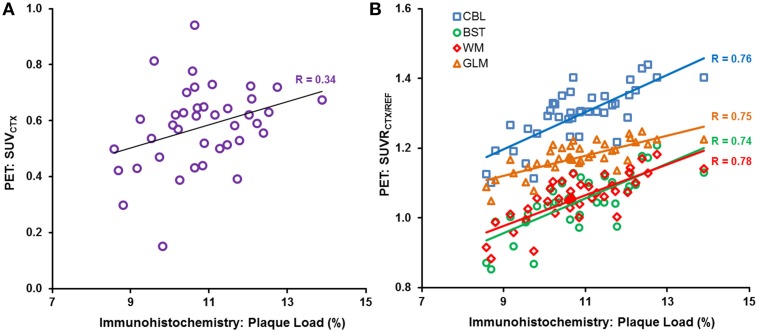
Individual (A) SUVCTX and (B) SUVRCTX∕REF PET correlations (expert manual fusion) with gold standard plaque load (%), as assessed by histochemistry, in (N = 40) PS2APP mice aged 13–16 months, are illustrated for SUVCTX (purple circles) and the different reference regions, i.e., cerebellum (CBL, blue squares), hindbrain white matter (WM, red diamonds), brain stem (BST, green circles), and global mean (GLM, orange triangle).